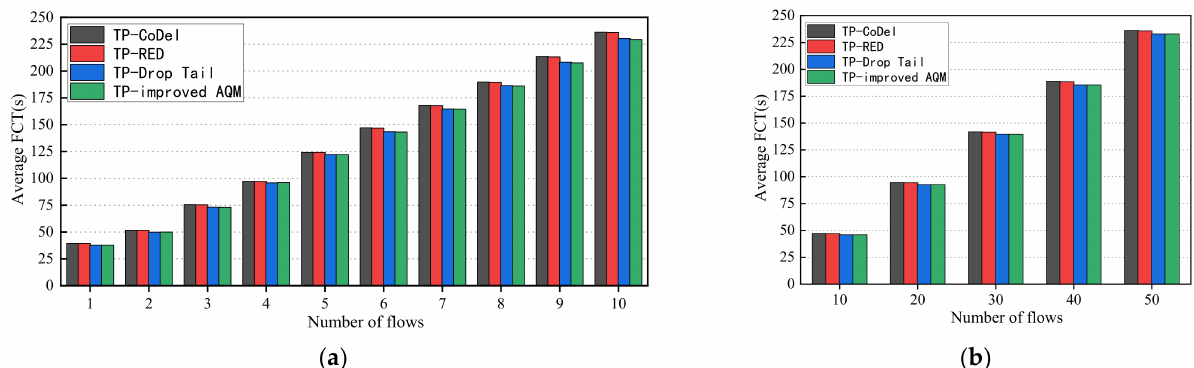
Figure 12. The average FCT under different numbers of ICN flows: ( a ) the case of low number of flows; ( b ) the case of high number of